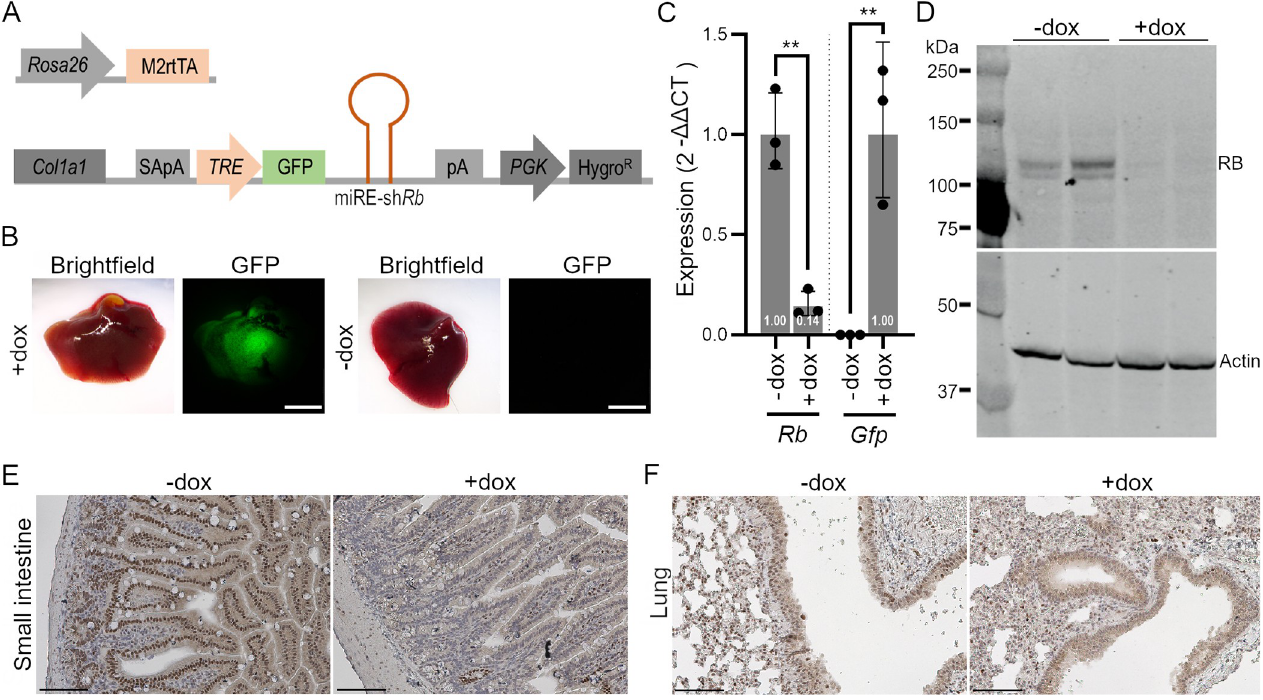
Fig 1. Generation of sh Rb mice to knock-down RB in vivo . A. Schematic representation of the transgenes used to generate sh Rb mice. M2-rtTA, M2 reverse tetracycline-controlled transactivator; SA, splice acceptor; pA, polyadenylation signal; TRE, tetracycline response element; GFP, green fluorescence protein; PGK, Phosphoglycerate kinase; Hygro R , Hygromycin resistance. B. Representative images of GFP fluorescent signal in livers of doxycycline (dox)-treated and control sh Rb mice 1.5 weeks after dox treatment (n = 2). Scale bar, 4mm. C. RT-qPCR analysis of Rb and Gfp in dox-treated and control livers from sh Rb mice 10 days after dox treatment. (n = 3 for each treatment group) (unpaired t test: �� , p < 0.01). D: Immunoblot analysis for RB from liver extracts from dox-treated (n = 2) and control sh Rb mice (n = 2), 4 weeks after dox treatment. Actin serves as a loading control. E-F : Representative immunohistochemistry images for RB in the small intestine (E) and lungs of 21 days dox-treated (+dox) and control mice (-dox). Note the loss of RB signal in the epithelial cells. Scale bar, 100 μ m.